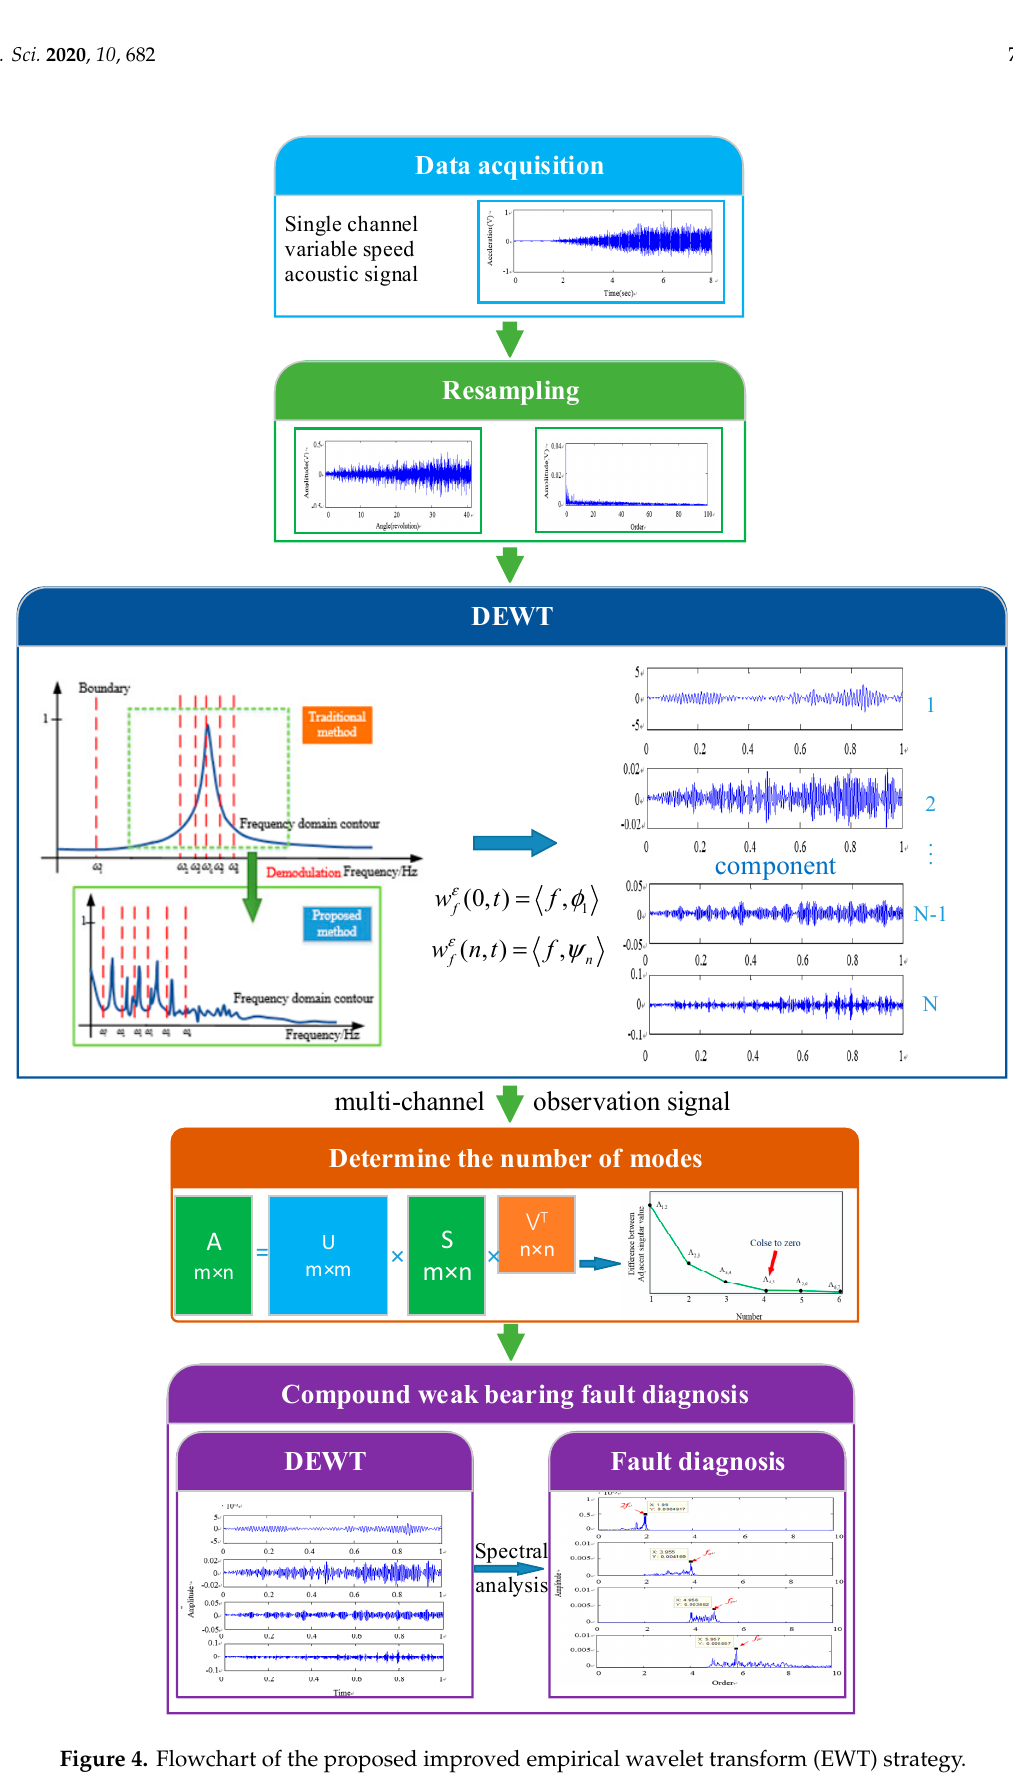
Figure 4. Flowchart of the proposed improved empirical wavelet transform (EWT) strategy.